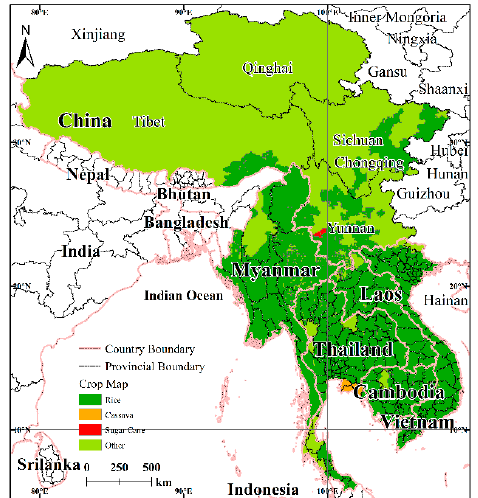
Figure 4. Distribution of crops in the LMR.